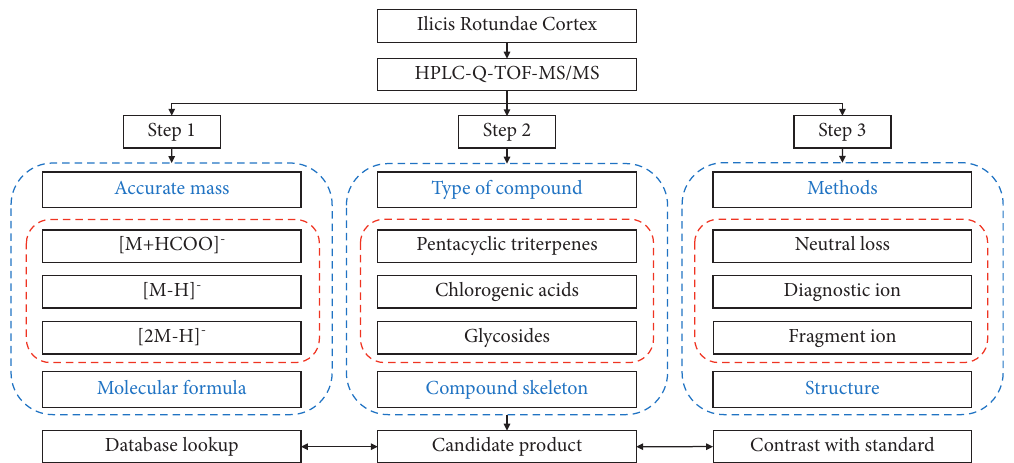
Figure 1: Schematic diagram of the integrative strategy.